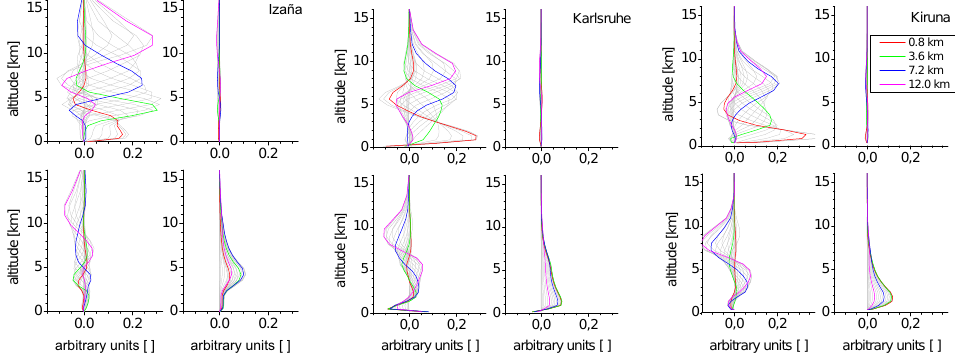
Figure 2. Same as Fig. 1 but for the kernels in the {humidity, δ D} proxy state basis (kernel matrix A 0 , Eq. 4). In agreement with Schneider et al. (2012) the cross-correlations are multiplied by the factors 12.5 (lower left panel in each subgraph) and 0.08 (upper right panel).